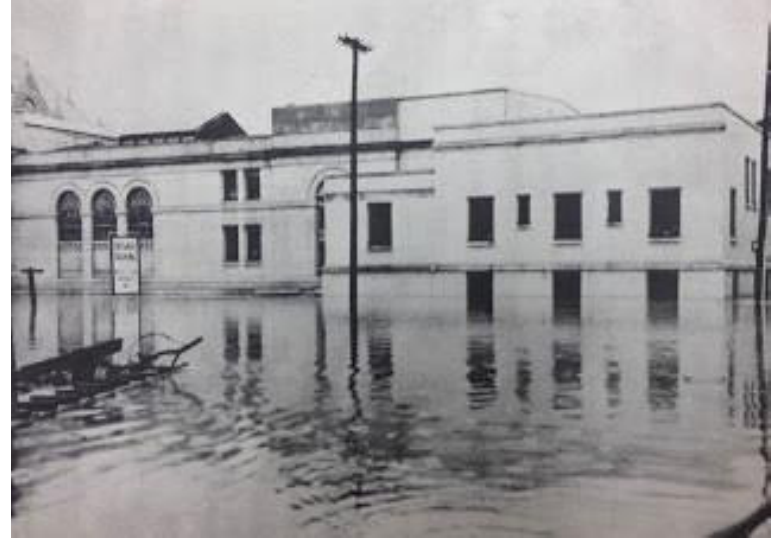
Figure 1 View of the back of James V. Brown Library during the 1936 flood. From C. Waters, 1936, Flood: West Branch Valley's Answer to Disaster